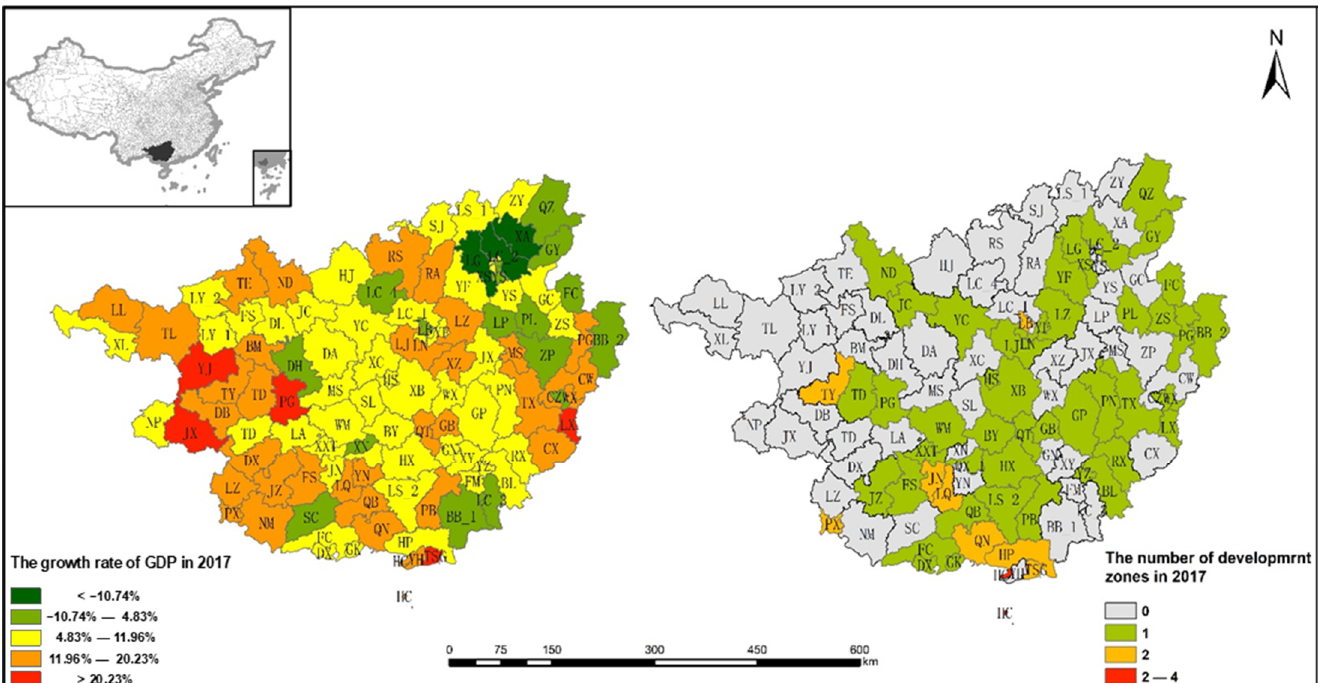
Figure 1. The establishment of development zones in Guangxi from 1991 to 2017.